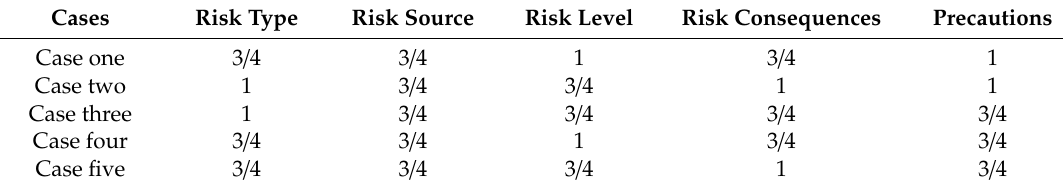
Table 8. Attribute-based semantic similarity calculation results.